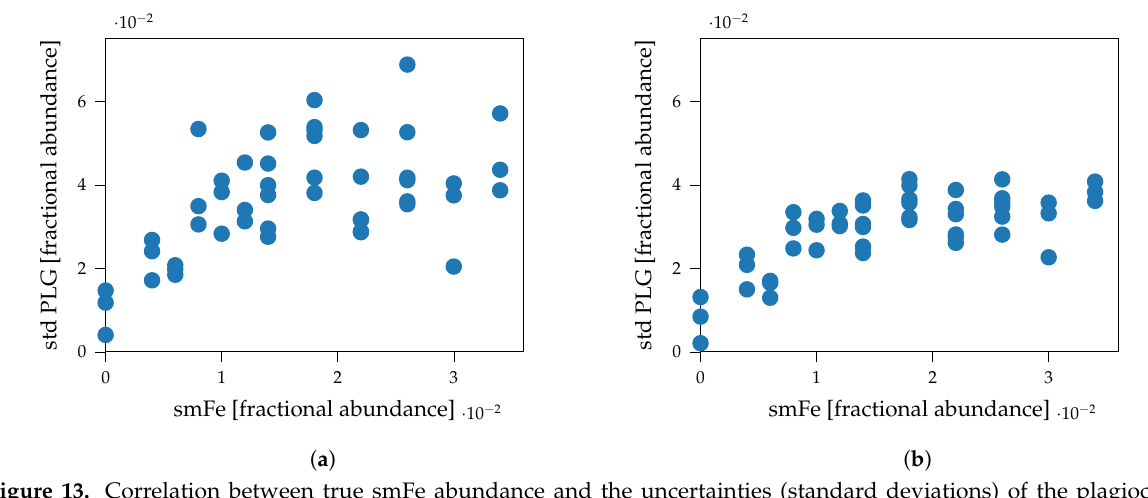
Figure 13. Correlation between true smFe abundance and the uncertainties (standard deviations) of the plagioclase abundance. It can be seen that the uncertainties generally decrease with the elemental prior. ( a ) Without prior; ( b ) TiO 2 and Al 2 O 3